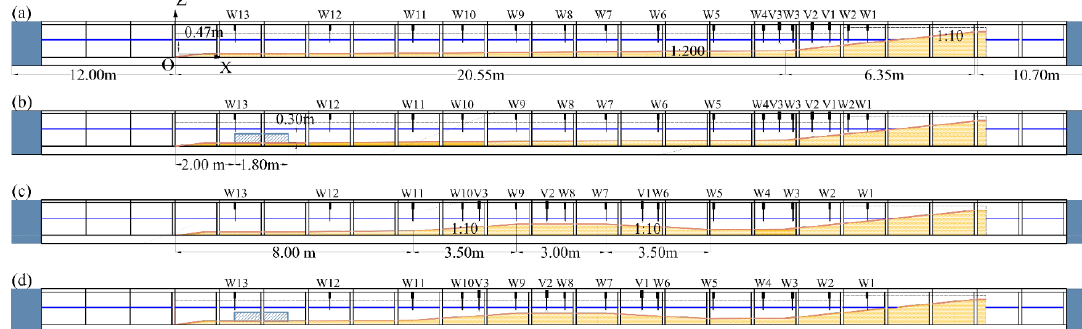
Figure 2. Experimental layout and four profile types: ( a ) B-N; ( b ) B-AR; ( c ) B-ASB; and ( d ) B-ASB-AR (W and V indicate the wave gauges and acoustic doppler velocimeters (ADVs), respectively. From the intersection of beach and still water surface to the middle points of ASB and AR, the distances are 10 m and 20 m, respectively. The coordinate system is set in (a) where X and Z indicate horizontal and vertical axes with origin of O). Table 2. The horizontal positions of instruments (unit: m). Profile Wave Gauges